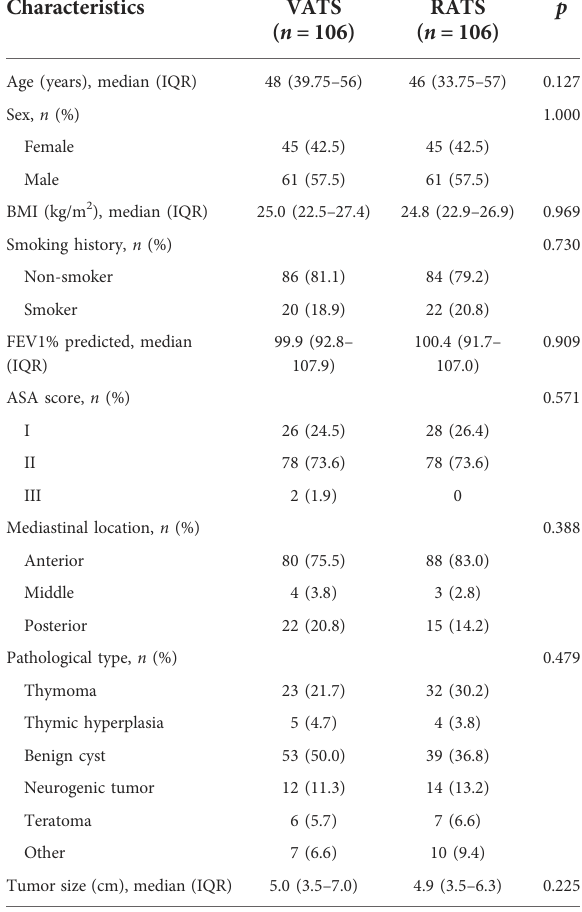
The incidence of overall postoperative complications (5.7% vs. 14.2%, p = 0.039), complications of grade II or less (3.8% vs. 12.3%, p = 0.023), and pneumonia (2.8% vs. 9.4%, p = 0.045) were signi fi cantly decreased in the RATS group. And hospitalization cost [¥ 49350.0 (IQR, 47938.7 – 51681.9) vs. ¥ 32551.9 (IQR, 29971.5 – 35555.3), p < 0.001] were signi fi cantly increased in the RATS group.